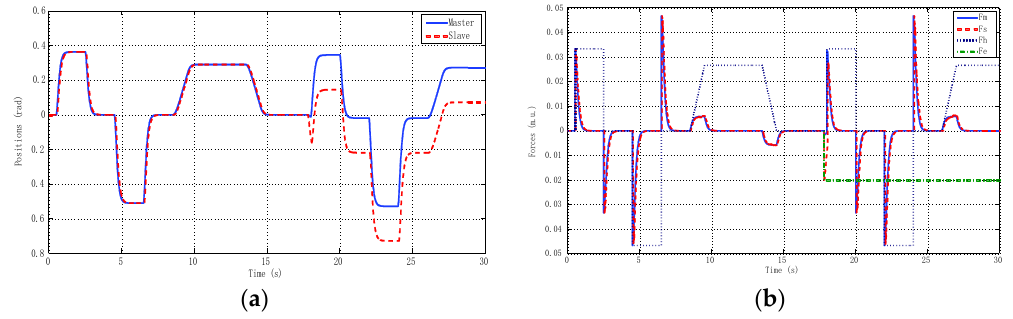
Figure 17. Remote teleoperation between Vigo and Manchester using linear models of master and slave. ( a ) Positions; ( b ) Forces.